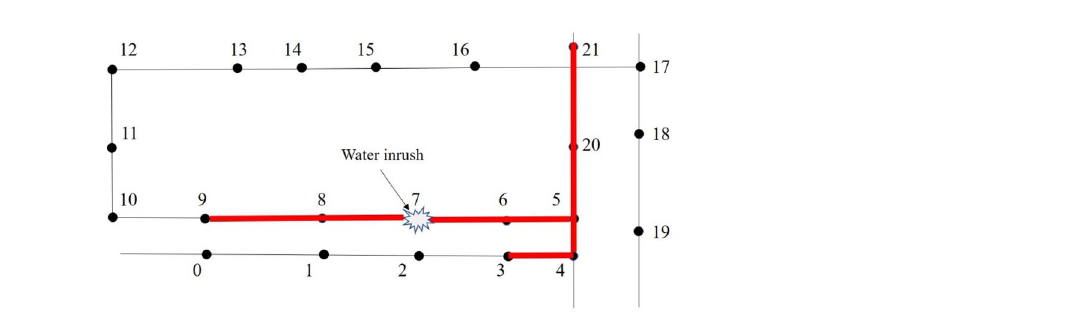
Figure 2. The spreading scope of water inrush at node 7.